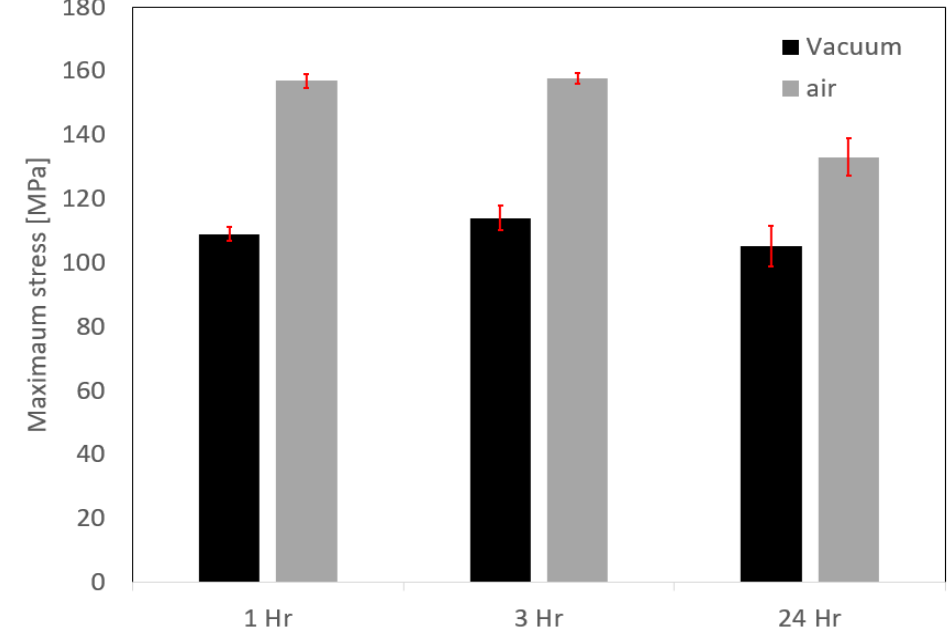
Figure 13. Tensile strength of 6061 – 1050 pairs after DB for different holding times and atmosphere. As stated in the introduction, the interface pressure can also influence the bonding quality. To estimate the interface pressure, the thermo-mechanical finite element model described in Section 3 was applied. In Figure 14, the time dependent pressure and tem- perature fields at different location along the interface are presented. It can be seen that the interface pressure is not constant during the bonding process. An initial pressure is obtained following the tightening of the bolt. During the heating process, when the tem- perature is increased, further high pressure develops due to the differences between the thermal expansion coefficients between the aluminum and the steel. A maximal pressure of 16 MPa develops during the early stages of the bonding process, when some tempera- ture gradient exists between the aluminum and steel parts of the bonding system (see Figure 1B). These high pressures drop to 8 – 10 MPa only when the steady state tempera- ture is reached. These values are in the same range as reported in previous studies [18 – 20]. Figure 14 shows that the pressure variation across the contact surface is small.